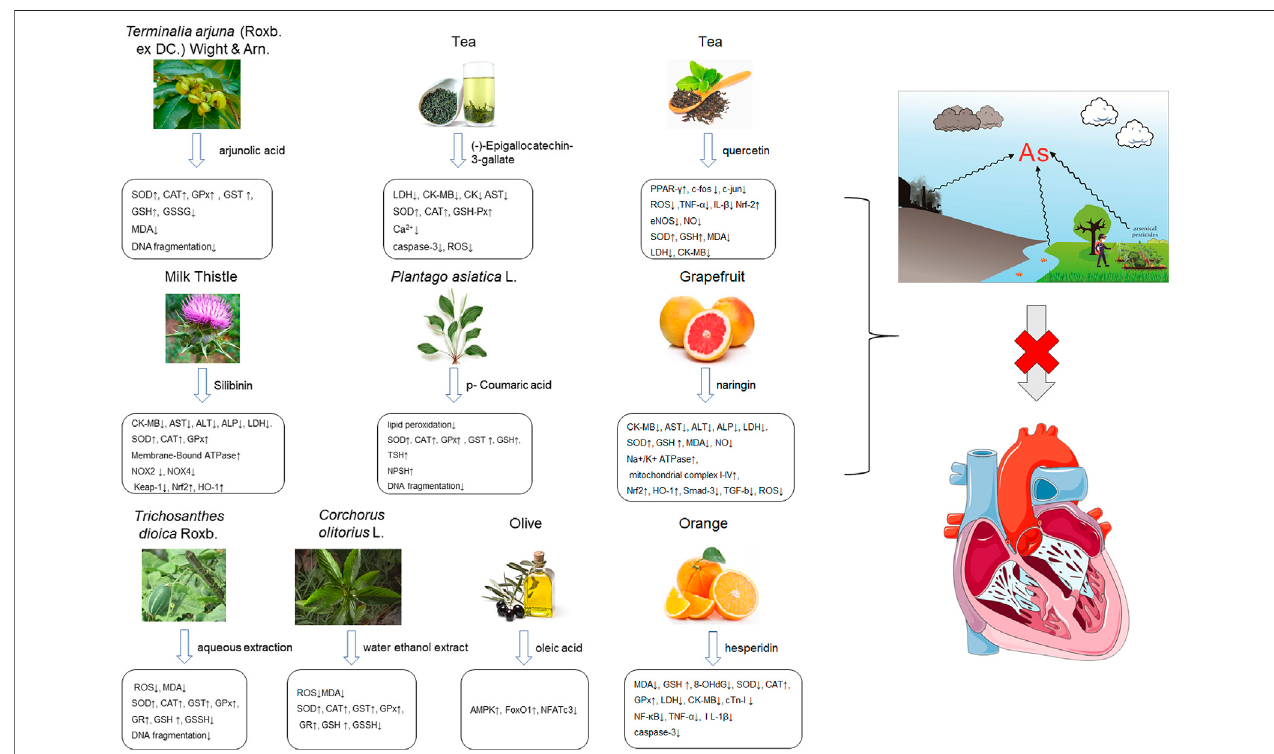
FIGURE 2 | The arsenic exposure routes and protective mechanisms of natural products against arsenic-induced cardiotoxicity. AST, Aspartate transaminase; ALT, alanine aminotransferase; ROS, reactive oxygen species; IL- β , interleukin- β ; eNOS, endothelial NOS; NOX2, NADPH oxidase two; NOX4, NADPH oxidase four; TSH, total sulfhydryl; NPSH, non-protein sulfhydryl; AMPK, adenosine monophosphate-activated protein kinase; GR, glutathione reductase.